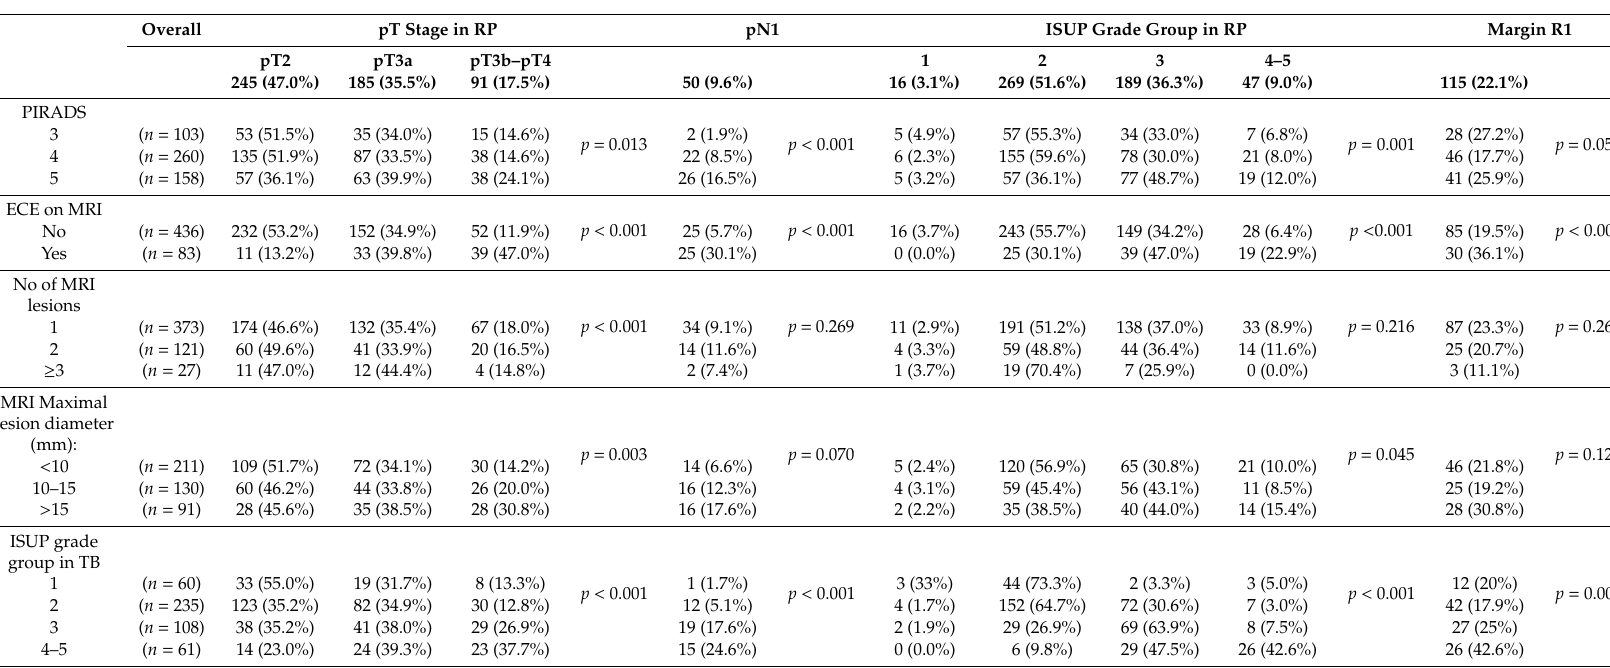
Table 2. Association between MRI characteristics and Pathological features in radical prostatectomy specimens and Biochemical